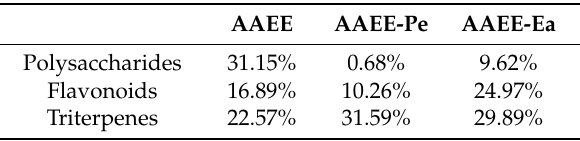
The contents of polysaccharides, flavonoids, and triterpenoids in AAEE, AAEE-Pe, and